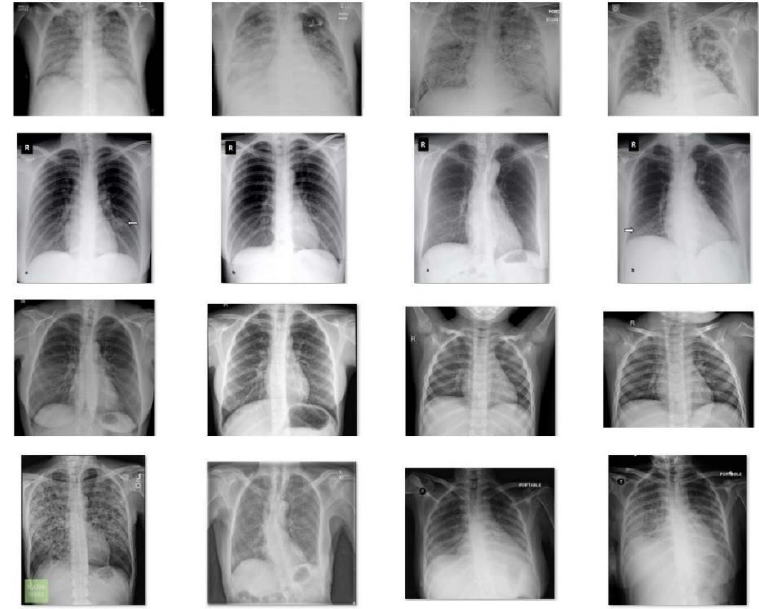
Figure 4. Sample Images.